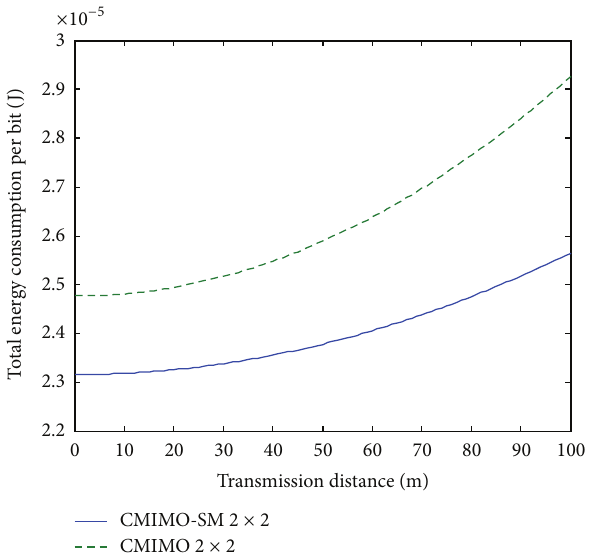
Figure 7: Total energy consumption per bit over d , 3 bits transmis- sion.